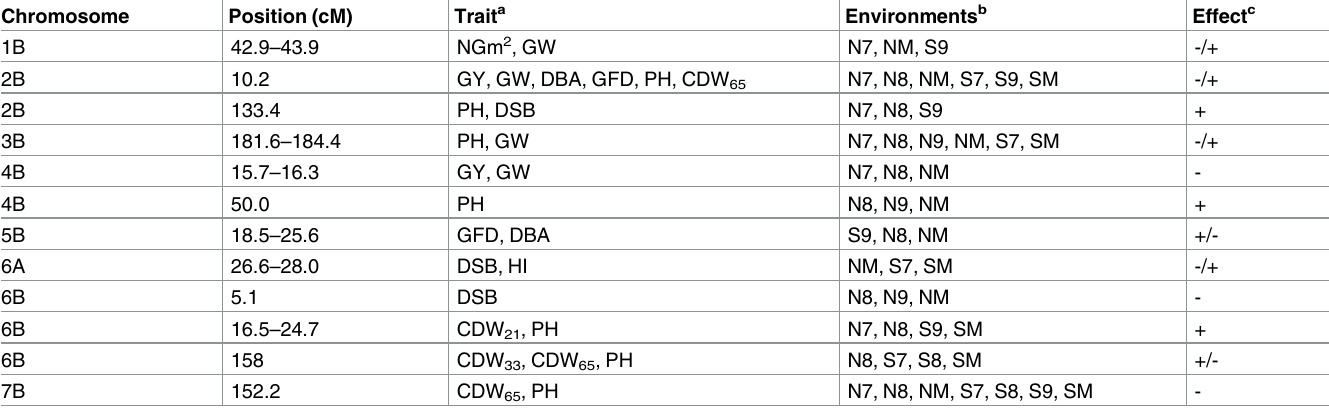
Table 2. Chromosome regions containing the most stable MTAs.